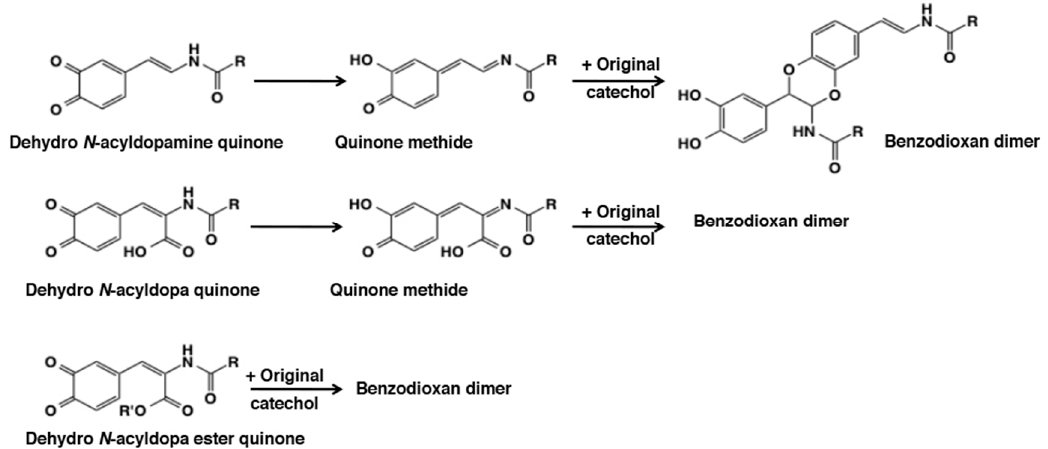
Figure 22. Reaction of side chain desaturated quinones producing benzodioxan dimers [19,62,113–